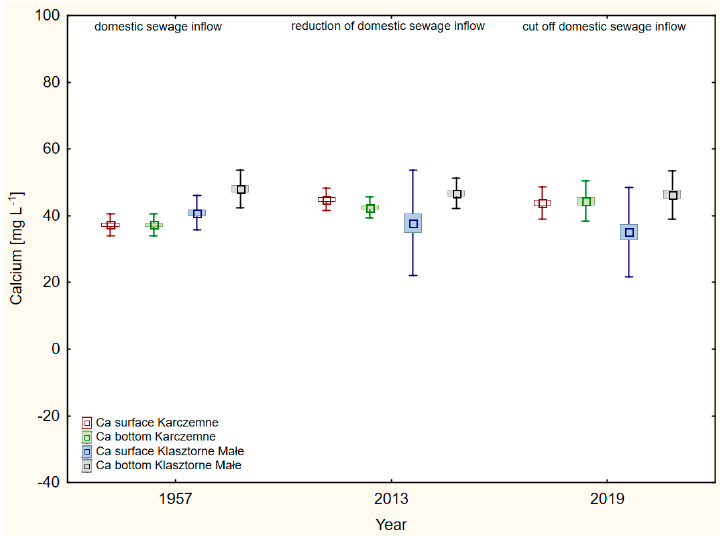
Figure 5. Mean annual values of calcium content (box ± SEM; whisker plots ± SD) in the water of Karczemne and Klasztorne Ma ł e lakes.